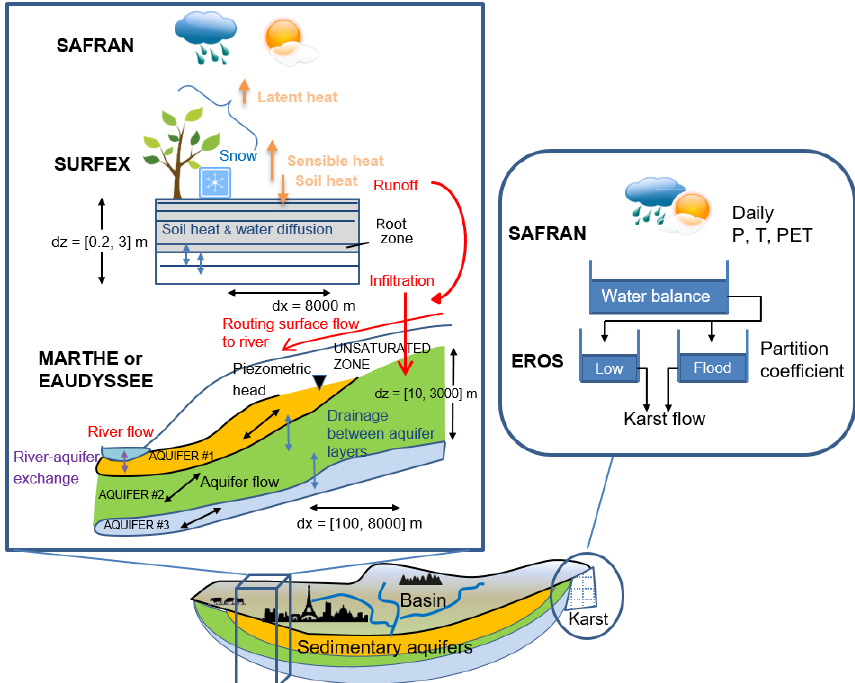
Figure 1. Scheme of the AquiFR physical system. The simulation of the watersheds depends on its hydrogeologic characteristics. For sedi- mentary basins, the transfer of water within the watersheds is estimated by MARTHE or EauDyssée. It accounts for flows in the unsaturated zones, to (red thin arrow) and in the rivers, in (black arrows) and between (blue arrows) aquifer layers, as well as the exchange between the river and the aquifer (purple arrow). The temporal resolution is daily, and the spatial resolution varies from 100m to a maximum of 8000m. The depth of the deepest aquifer layer can locally reach about 1000m. The 8km spatial partition of the flow between surface runoff and groundwater recharge (red thick arrows) is estimated by the SURFEX land surface scheme. It solves the water and energy budget at a 5min time step. It accounts for the local type of vegetation and soil, the presence of snow, and a multilayer soil that can reach a depth of 3m. The atmospheric forcing is provided by SAFRAN. For the karstic systems, the EROS conceptual model is used. It represents each karstic system as lumped basins based on a reservoir approach at a daily timescale. The incoming atmospheric forcing is provided by